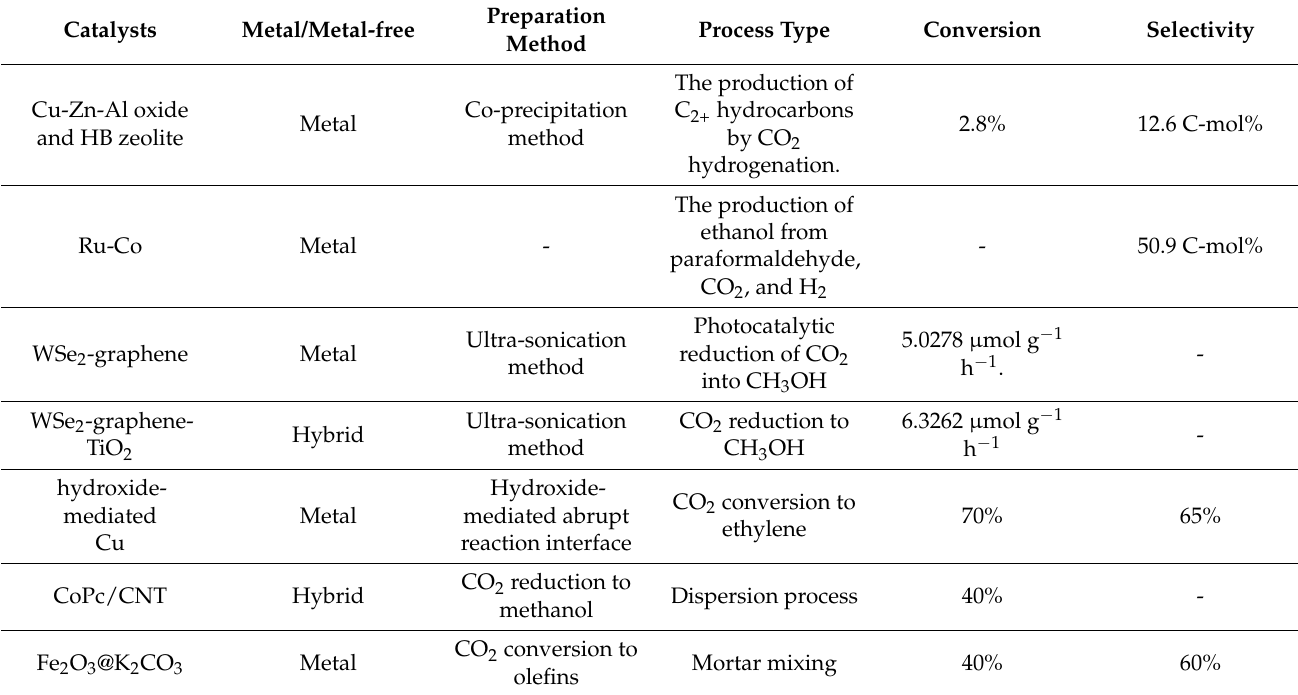
Table 1. Some of the main catalysts used in the hydrogenation of CO 2 to hydrocarbon